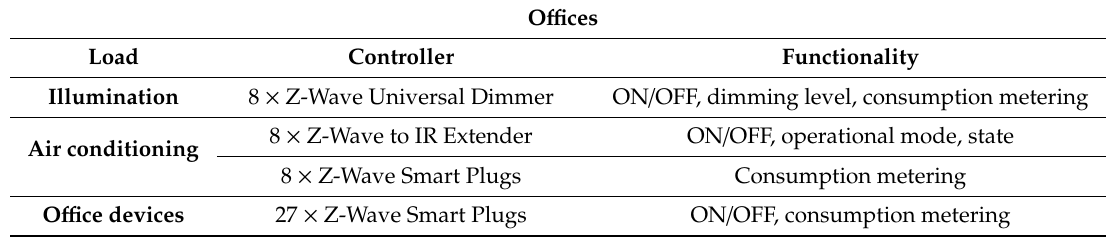
Table 2. Metering equipment.